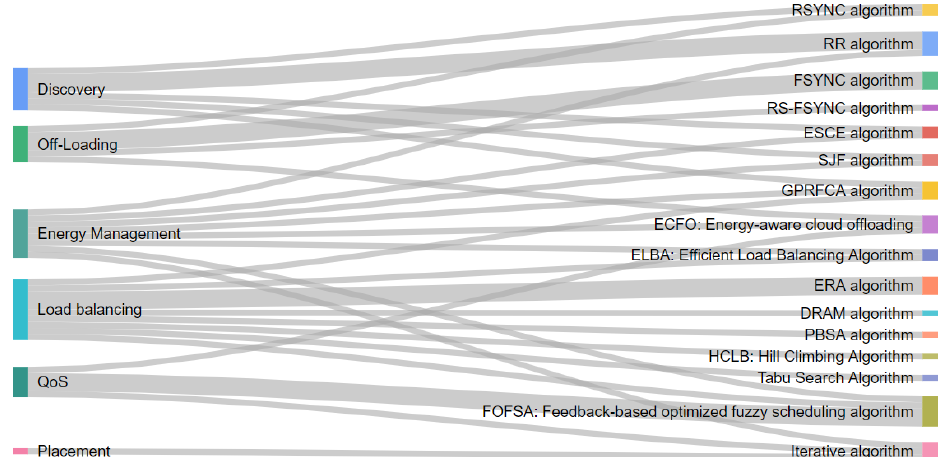
Figure 4. Classification of resource management